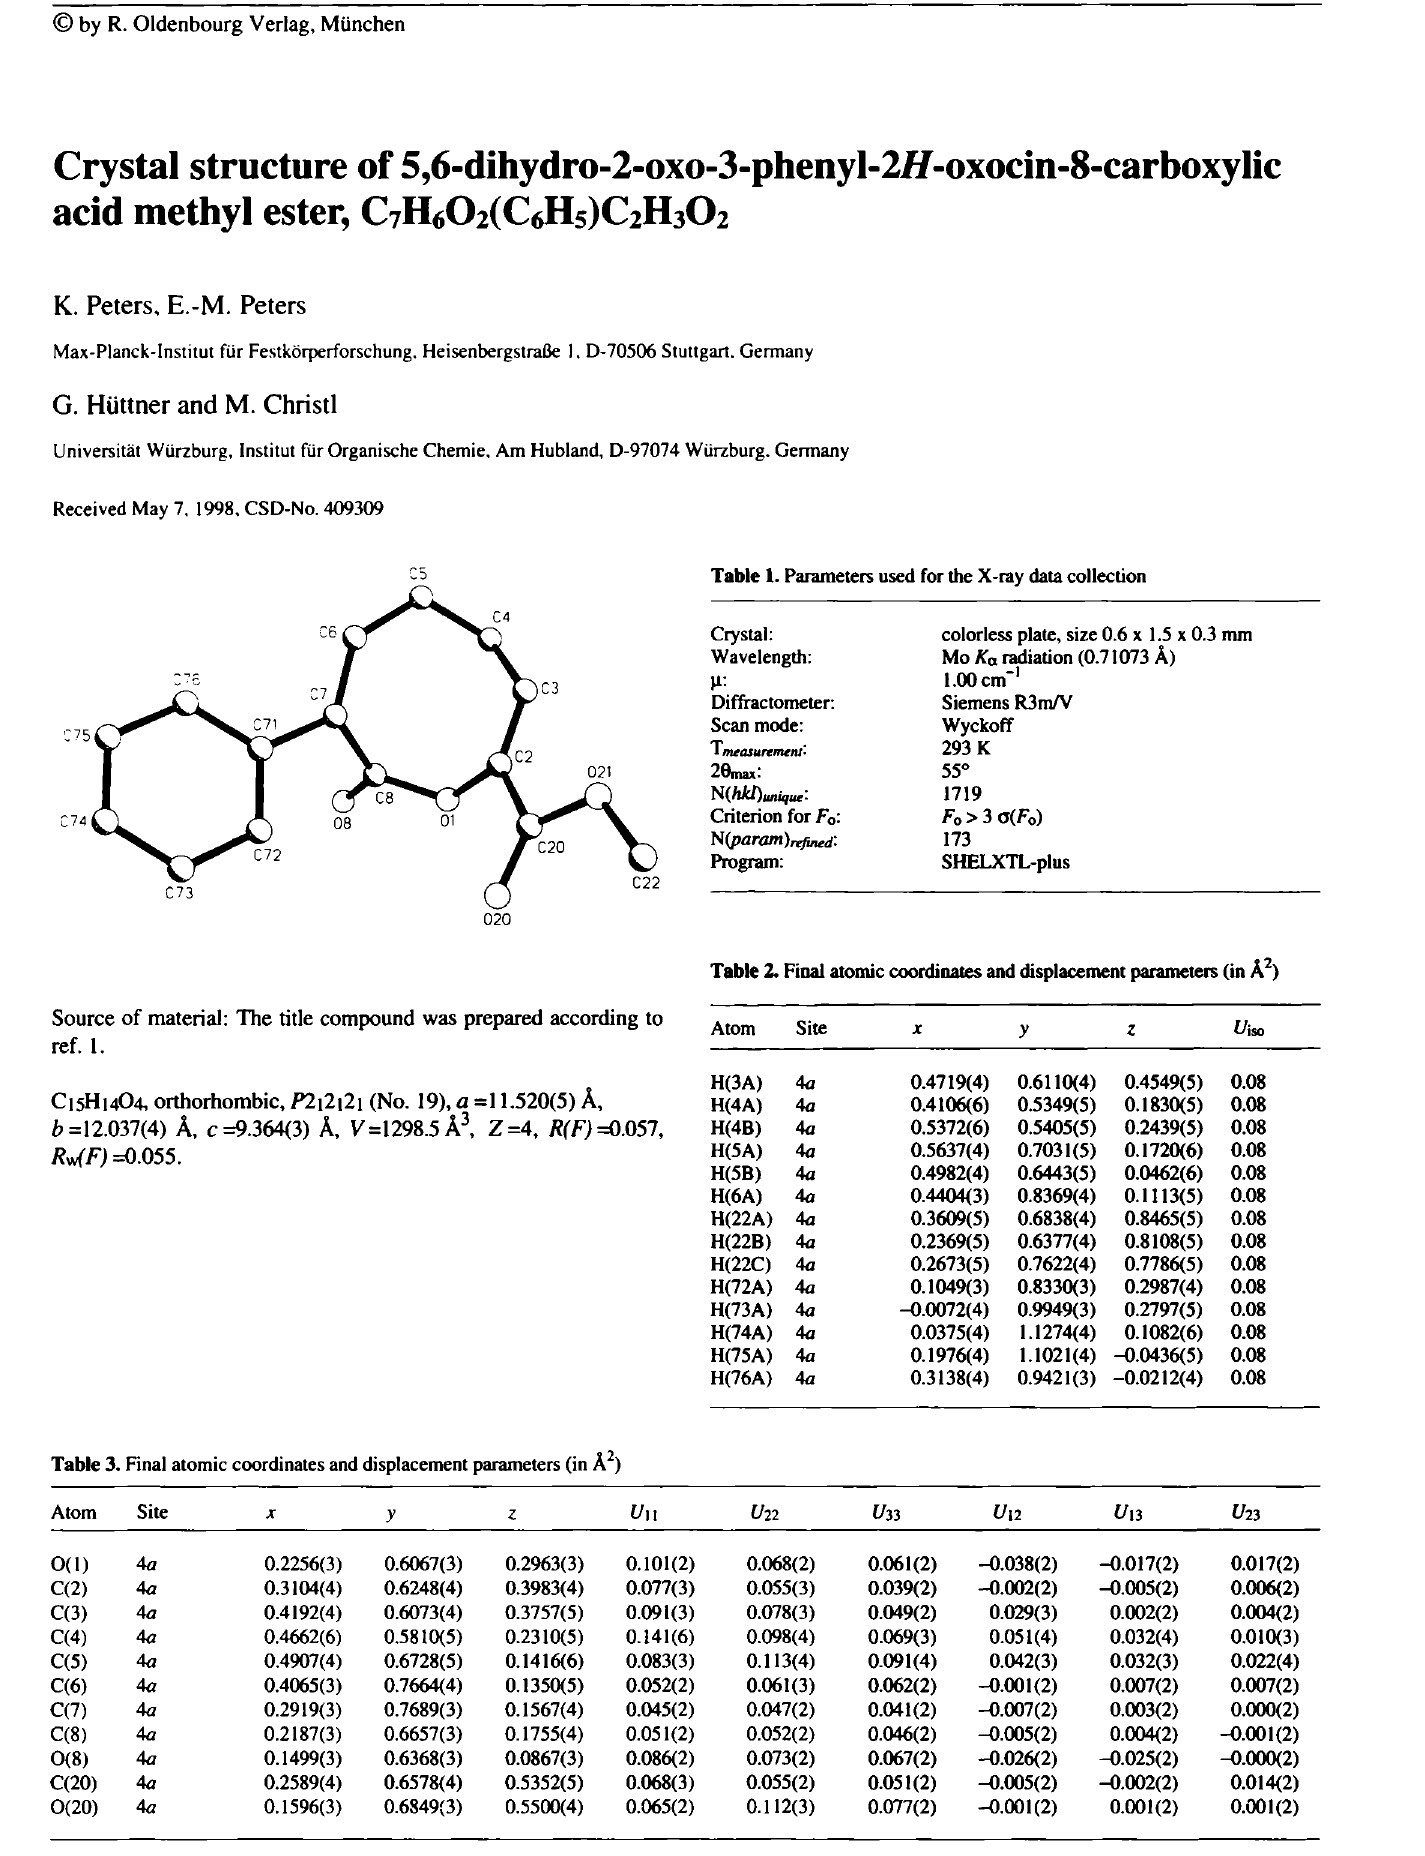
Table 3. Final atomic coordinates and displacement parameters (in